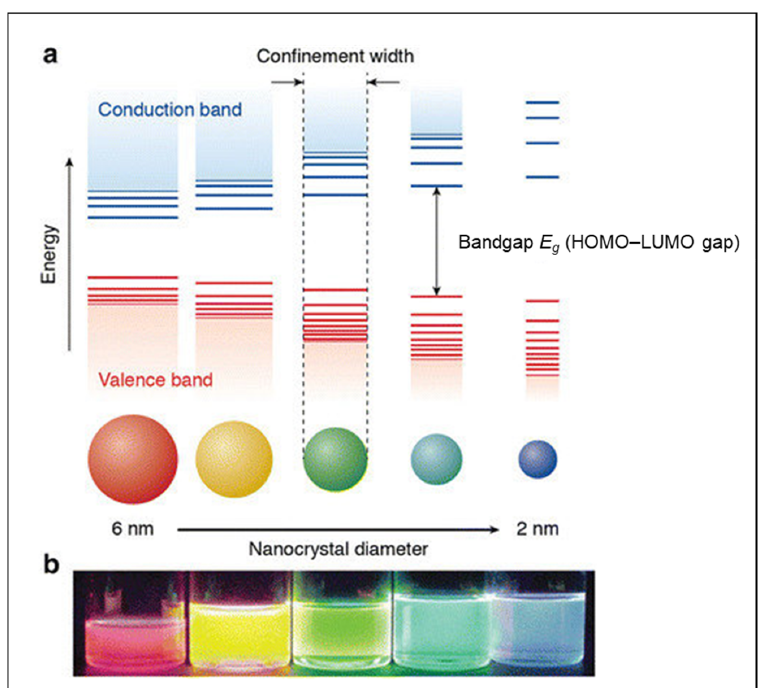
Figure 4. A Schematic representation of the quantum confinement effect: ( a ) The bandgap (or HOMO–LUMO gap) of the semiconductor nanocrystal increases with decreasing size, while discrete energy levels arise at the band-edges; ( b ) Five colloidal dispersions of cadmium–selenium quantum dots (CdSe QDs) under UV excitation ranging from 6 nm (red) to 2 nm (blue). Adapted with permission from ref. [17,18]. Copyright 2021 Springer Link (http://creativecommons.org/li ‐ censes/by/4.0/; accessed on 7 June 2021).